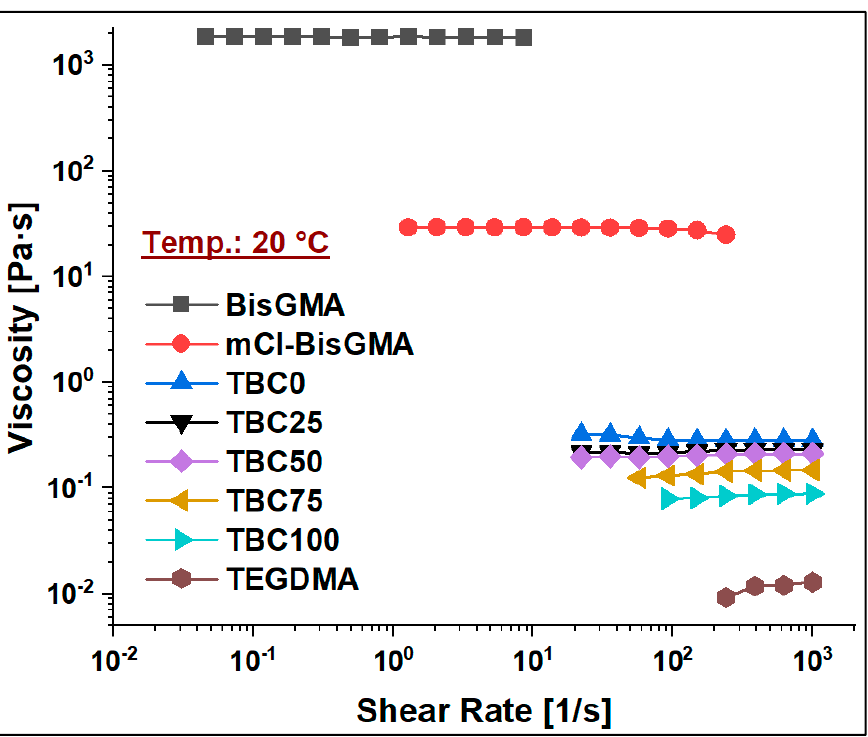
Figure 7. Viscosity curves of BisGMA, mCl-BisGMA, and resin mixtures TBC0–TBC100 at 20 °C.